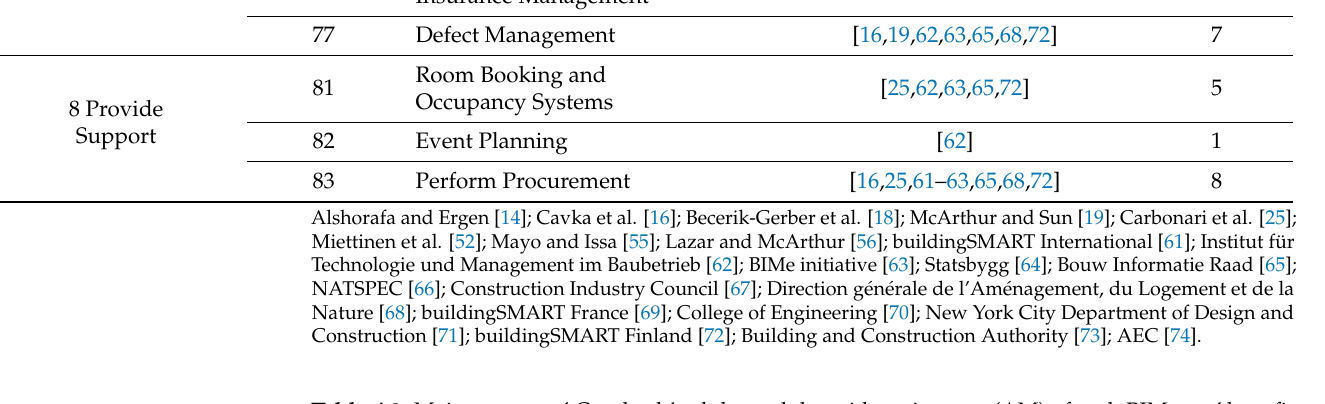
Table A2. Main processes’ Cronbach’s alpha and the arithmetic mean (AM) of each BIM uses’ benefit assessment with corresponding standard deviation (ST DEV), and